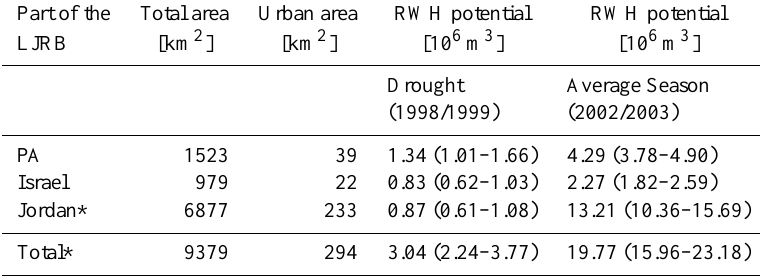
Table 2. Potentials of urban RWH in different parts of the Lower Jordan River Basin for the average season 2002/2003 and the drought season 1998/1999; uncertainty intervals are estimated by the 95% prediction interval of the RC-rainfall regression (Fig. 5).